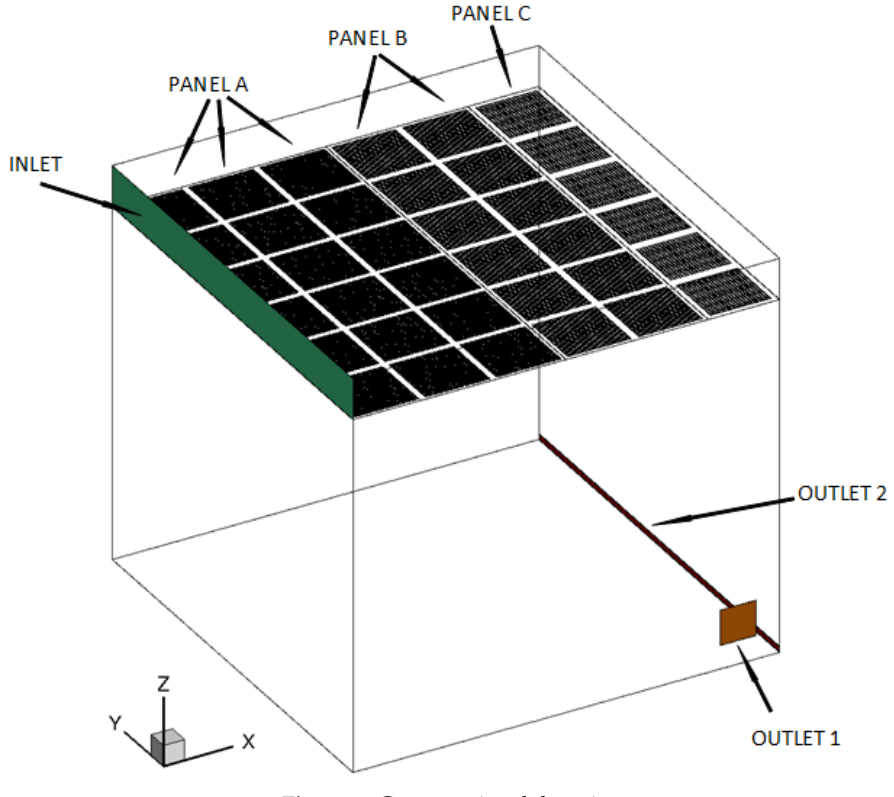
Figure 4. Computational domain.